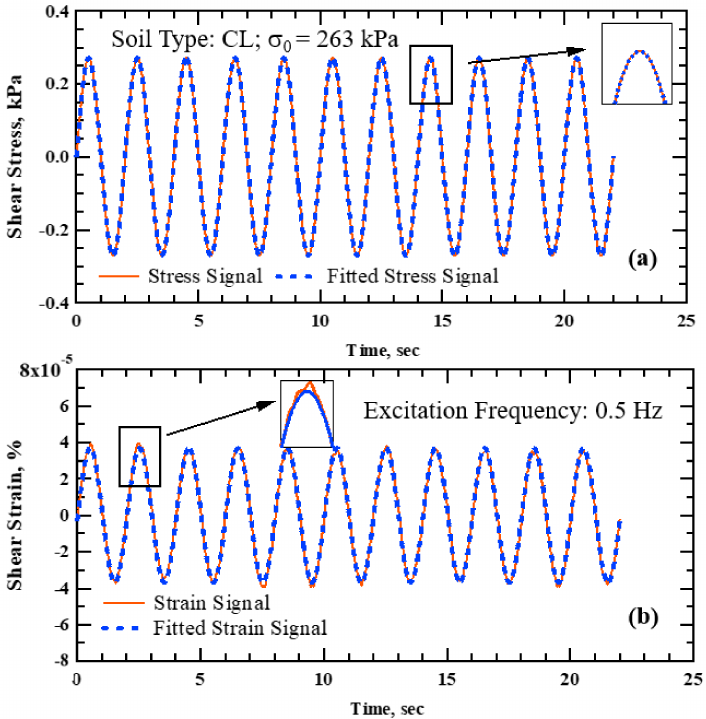
Figure 4. Fitting of the time series of ( a ) stress and ( b ) strain